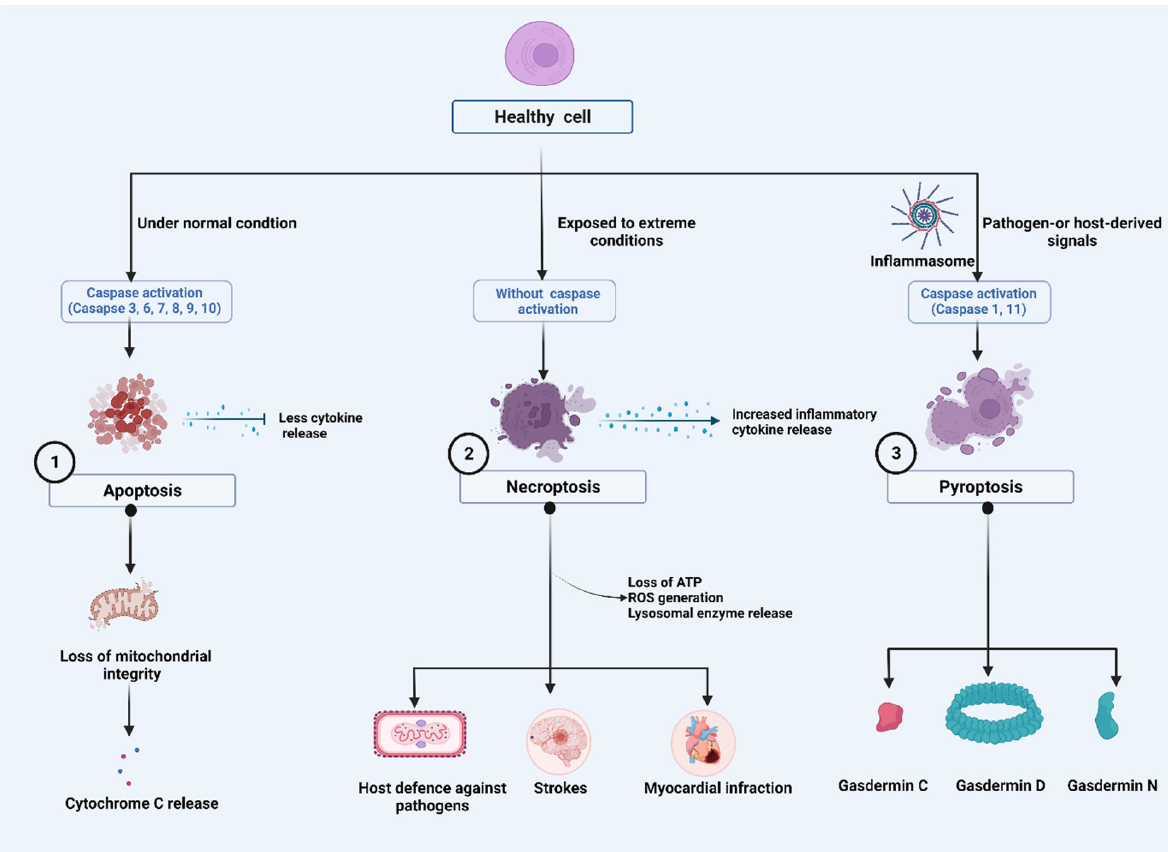
Figure 1. Major cell death pathways: ( 1 ). Harmless apoptosis: Mitochondria play a central role in the initiation of apoptosis. During early phases of cell death, cytochrome c (Cyt c) is often released from mitochondria. ( 2 ). A pathogenic mediator, necroptosis, plays a role in a variety of diseases and in the fight against viral infection. Despite having caspase activation, necroptosis plays a role in triggering and amplifying inflammation. Inflammatory responses are amplified by the activity of cytokines, which activate pro-inflammatory genes and lead to regulated cell death. Stress, infection, and injury can initiate the response by inducing regulated cell death directly as well as activating immune cells and cytokines. Receptor interacting protein-mediated reactive oxygen species (ROS) production, loss of ATP and lysosomal release can reactivate necroptosis, forming a positive feedback loop